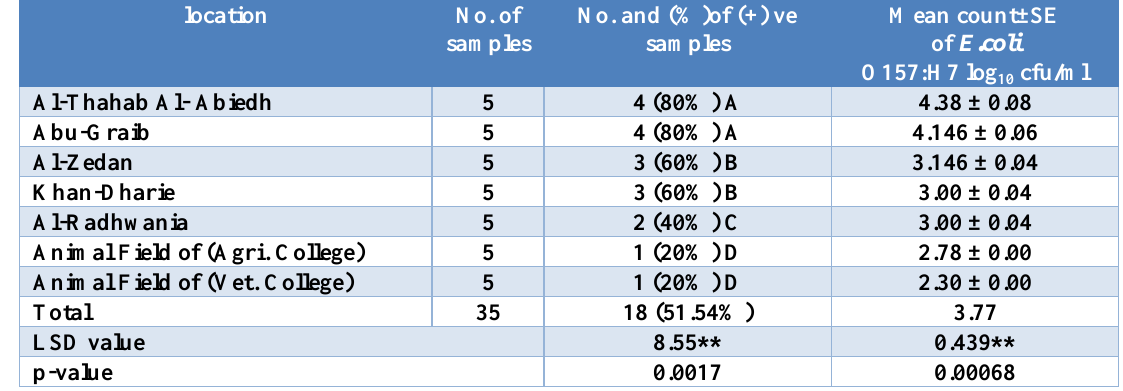
Table, 1: The prevalence (%) and count of E.coli O157:H7in raw milk samples from different villages surrounding Baghdad